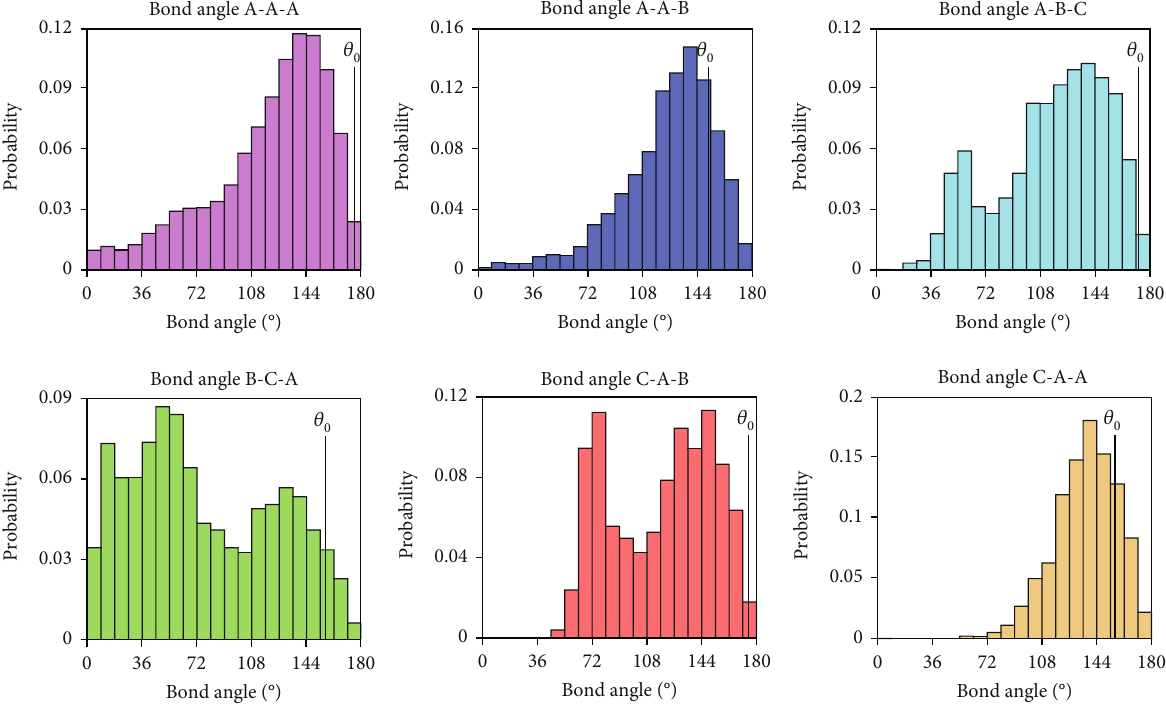
Figure 7: Probability fractions of values of di ff erent bond angles of the 100-chain coarse-grained PU at ε angles were smaller than the equilibrium bond angles ( θ